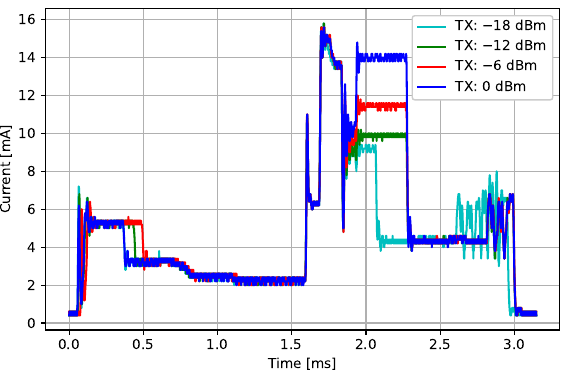
Figure 4. Current consumption profiles of BLE connection events for different TX power settings.